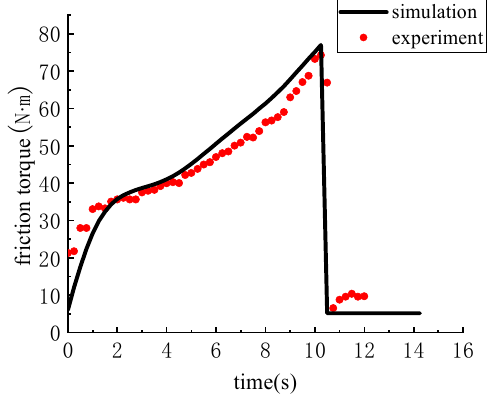
Figure 16. Torque curve for Test and Simulation.